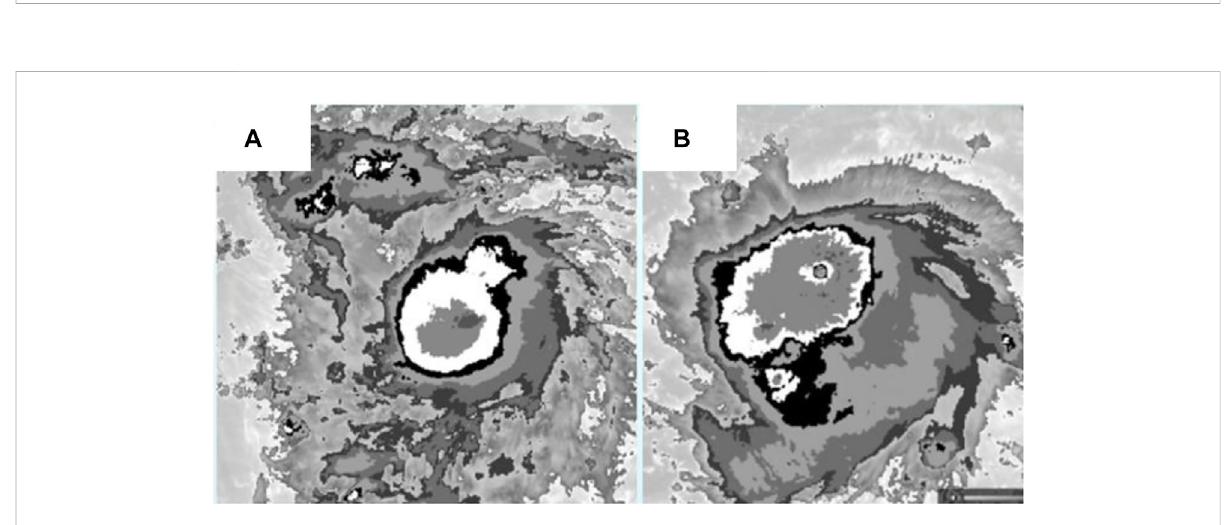
FIGURE 10 Infrared channel satellite cloud image of Typhoon 2114 “ Chanthu ” (A) 7 September 2021 00UTC (B) September 8,